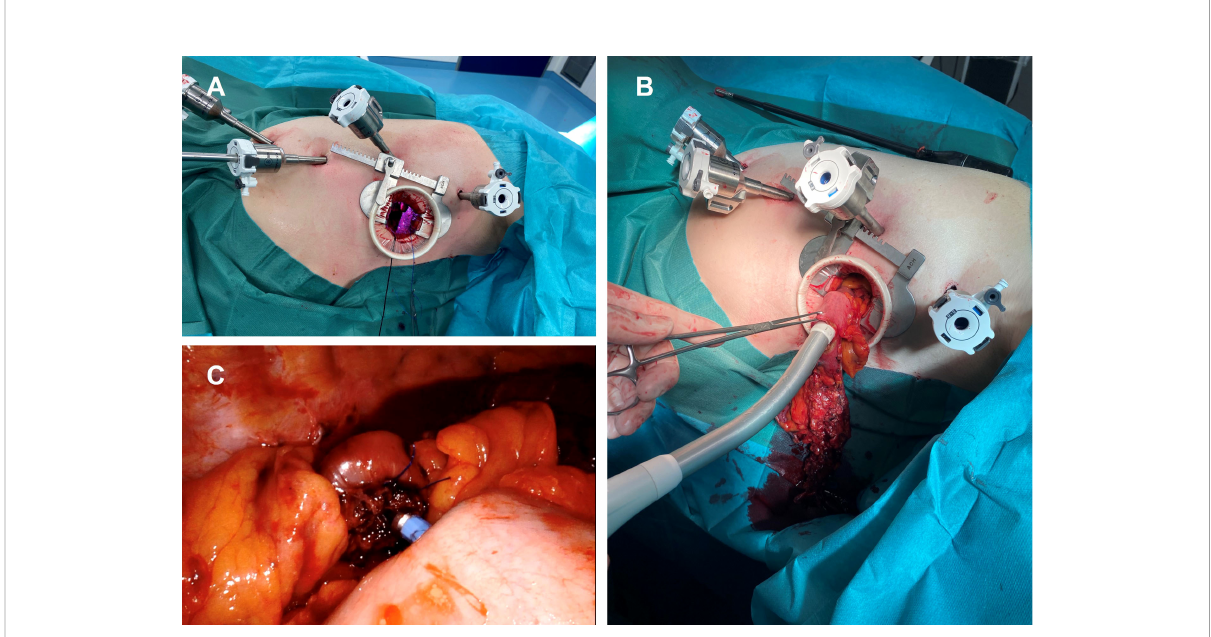
FIGURE 2 Robot-assisted circular stapled end-to-side esophagogastrostomy. (A) Thoracic port placement and small thoracotomy. (B) Insertion of the circular stapler into the gastric conduit. (C) Intrathoracic end-to-side